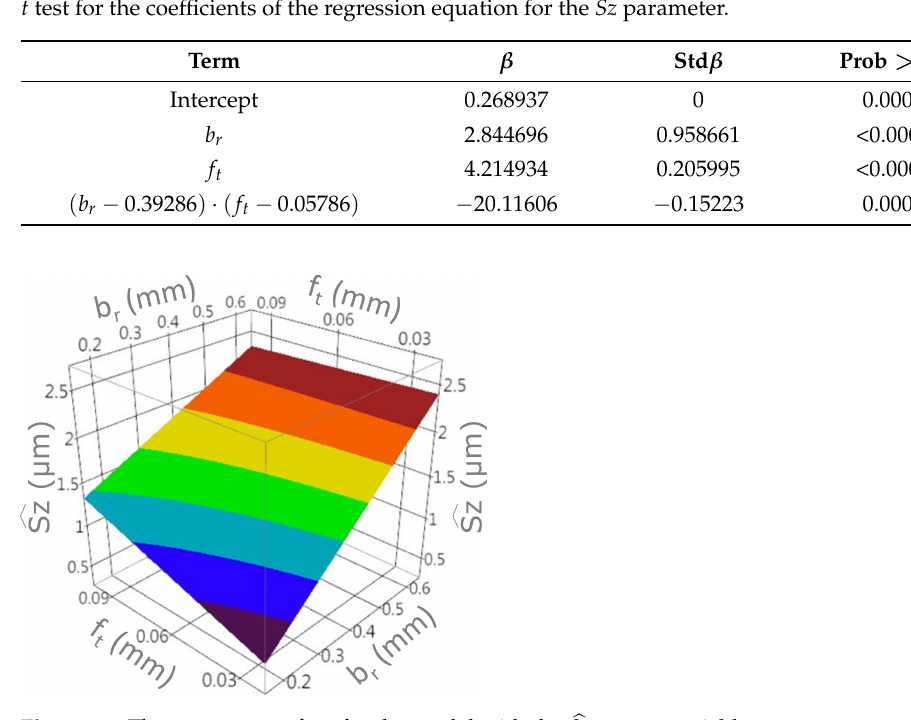
Figure 13. The response surface for the model with the (cid:98) Sz output